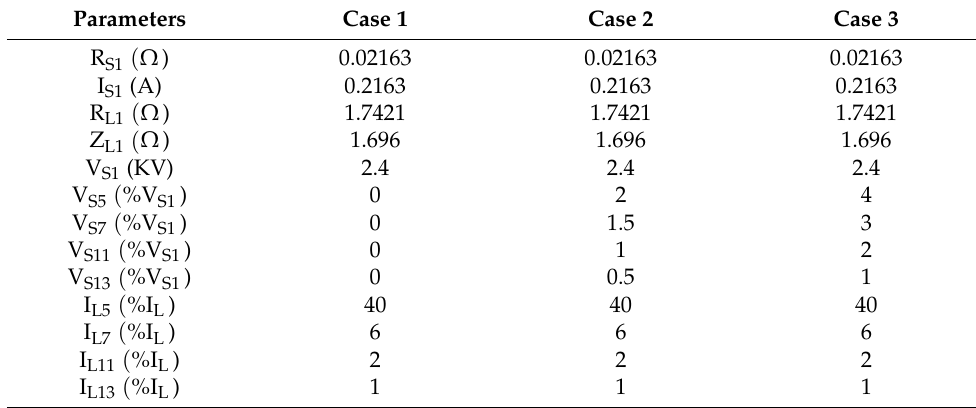
Table 2. The parameters of case studies for configuration 2 of HAPF.